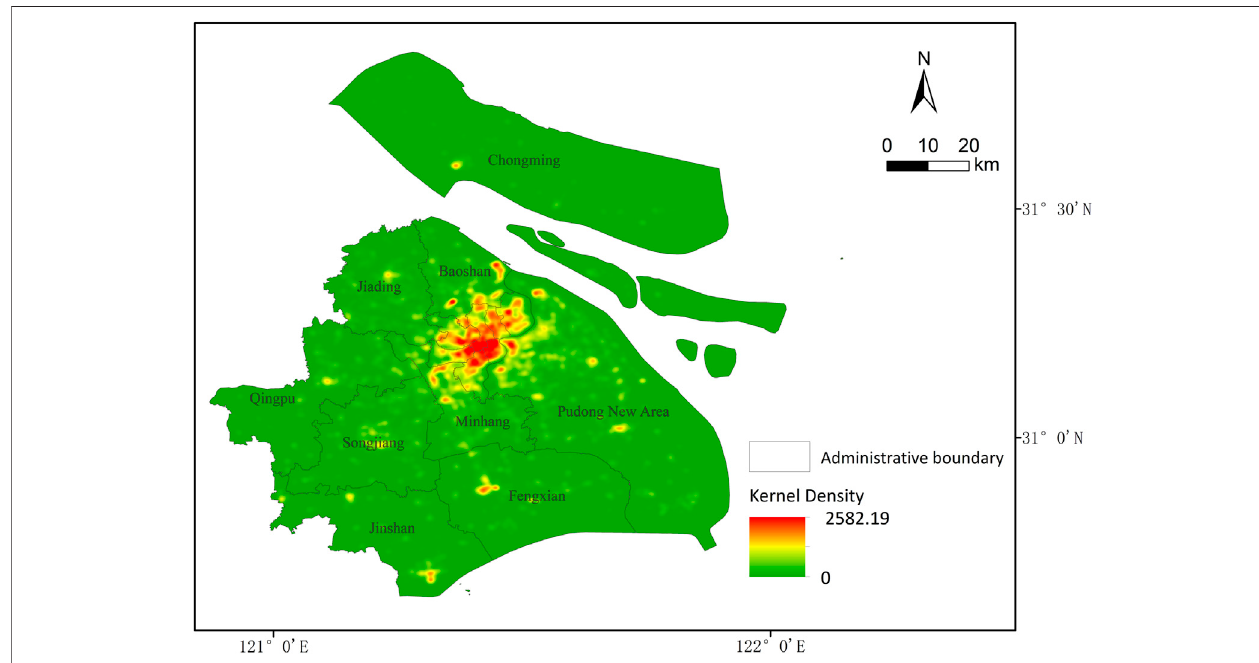
FIGURE 1 | Spatial distribution of POI kernel density in